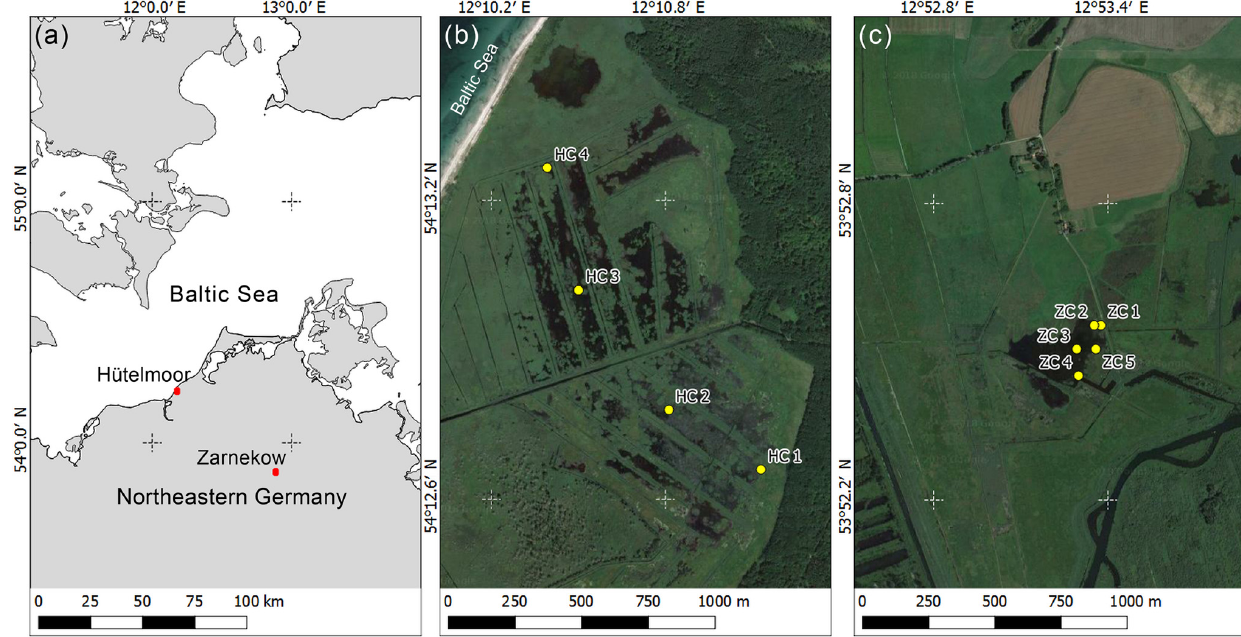
Figure 1. Location of study sites in northeastern Germany (a) and sampling locations within sites (b) Hütelmoor and (c) Zarnekow. Maps (b) and (c) are drawn to the same scale. Image source: (a) QGIS; (b) and (c) Google Earth via QGIS OpenLayers Plugin. Imagery date: 9 August